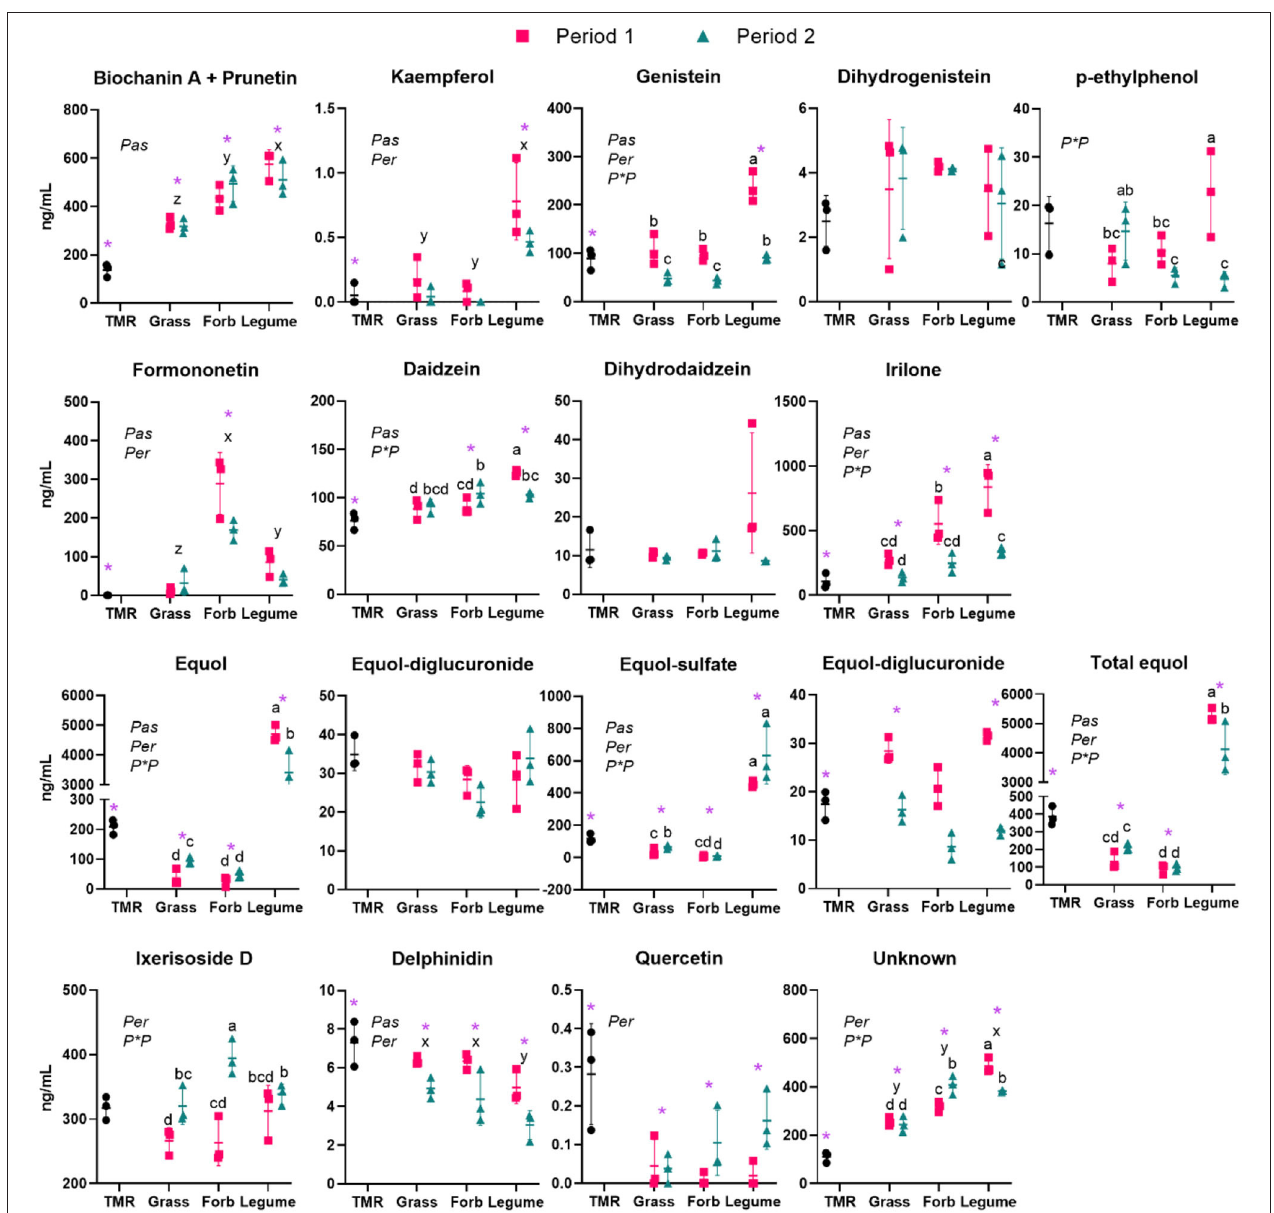
FIGURE 2 | The plant secondary compounds present in the plasma of the cows fed TMR (this was offered to all cows before starting the pasture trial), ryegrass-white clover mix (Grass), chicory-plantain mix (Forb), and Legume mix (Legume) for two periods during 2019 spring (Period 1 = April 29 to May 19 and Period 2 = May 19 to June 6). Shown are the data point for each plot ( n = 3 plots per group) in each treatment and period with mean and SD. Letters a, b, c, and d denote the statistical differences ( P < 0.05) between the various Pastures at each Period when Pasture × Period was significant (P*P), letters x, y, and z denote the statistical differences ( P < 0.05) between the various pastures (Pas). Purple asterisks denote the difference of various pastures with